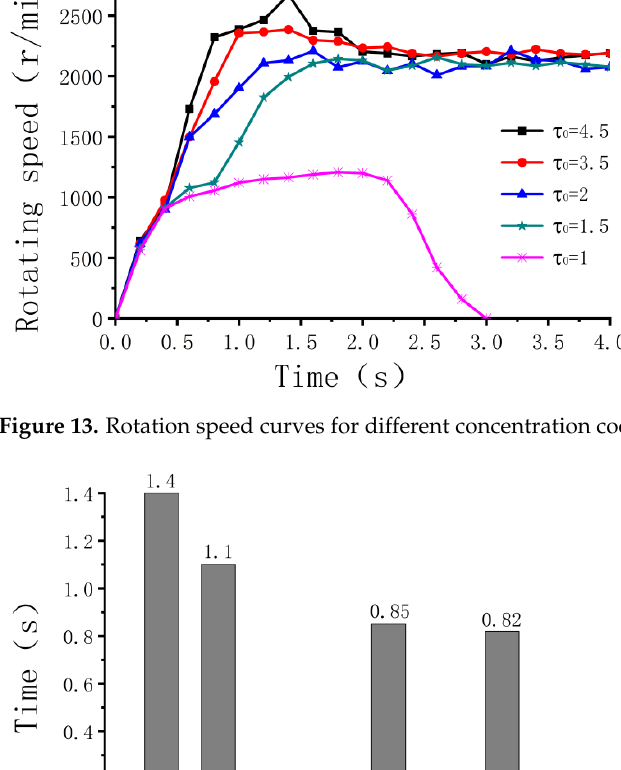
Figure 15. Rotation speeds for different oil–gas intervals during a cold start.